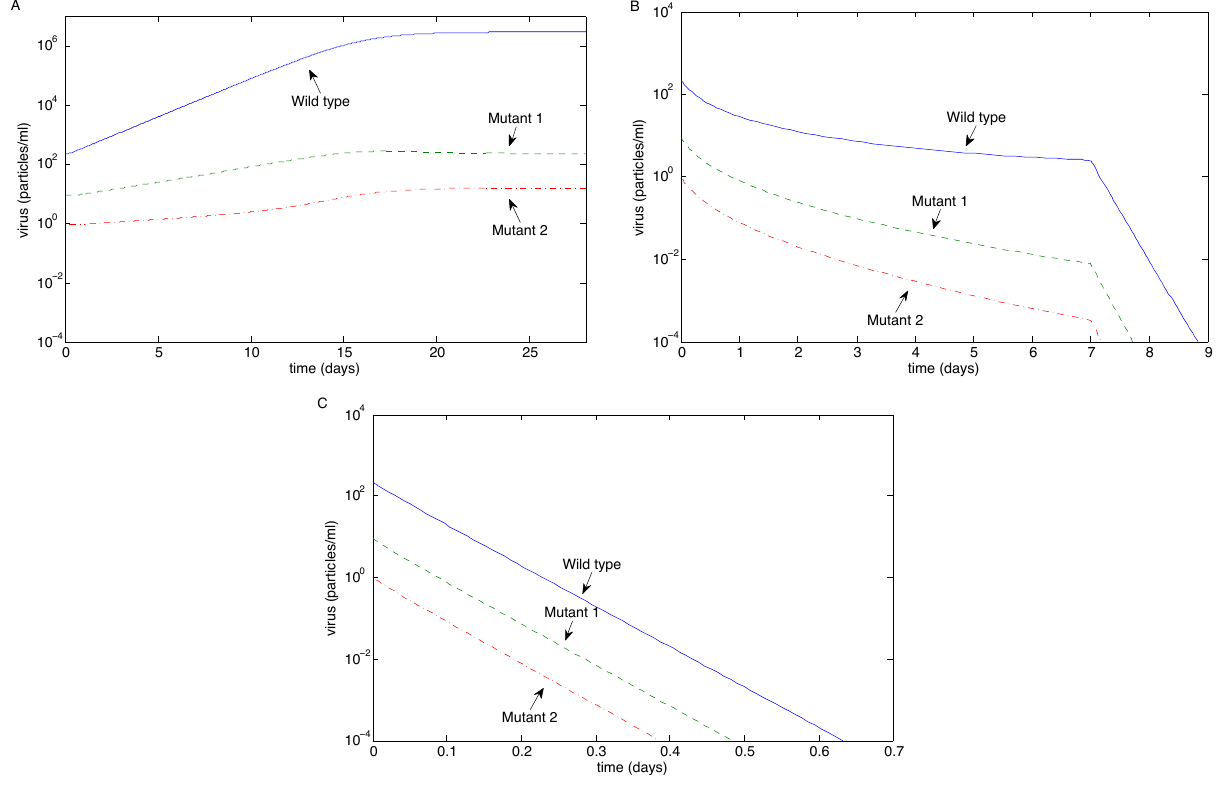
Figure 3. The long-term outcome for virus strains using the sample values in Table 1 for the case of equal virus neutralization rates ( p factor m varies. ( A ) m = 1 ; ( B ) m = 10 ; ( C ) m = 50